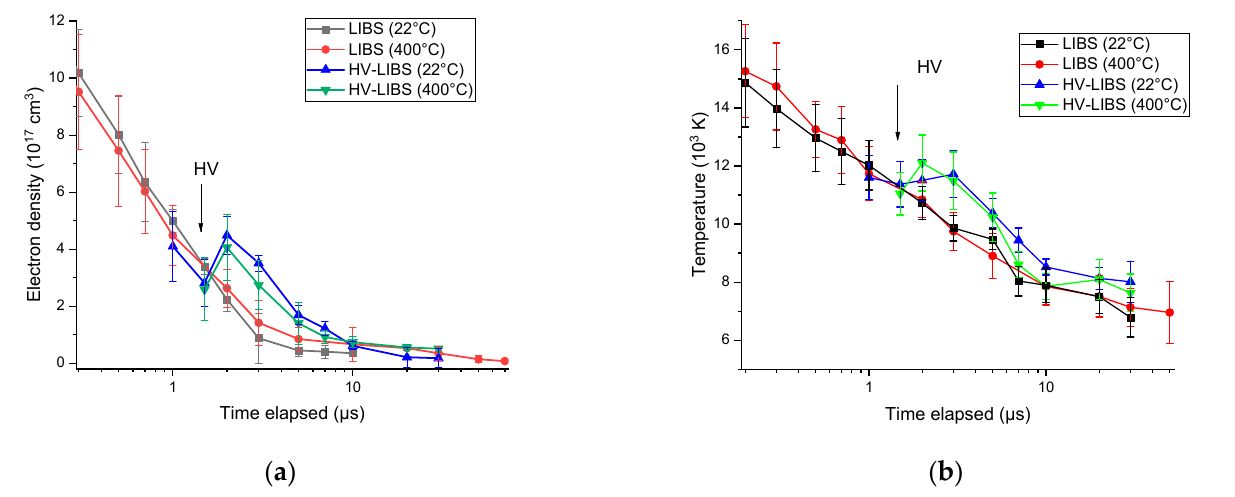
Figure 5. ( a ) Temporal evolution of the electron density, and ( b ) plasma temperature, obtained for an ablation irradiance of 50 GW cm − 2 , a discharge voltage of 12 kV (HV ‐ LIBS) and heating the target up to 400 °C.